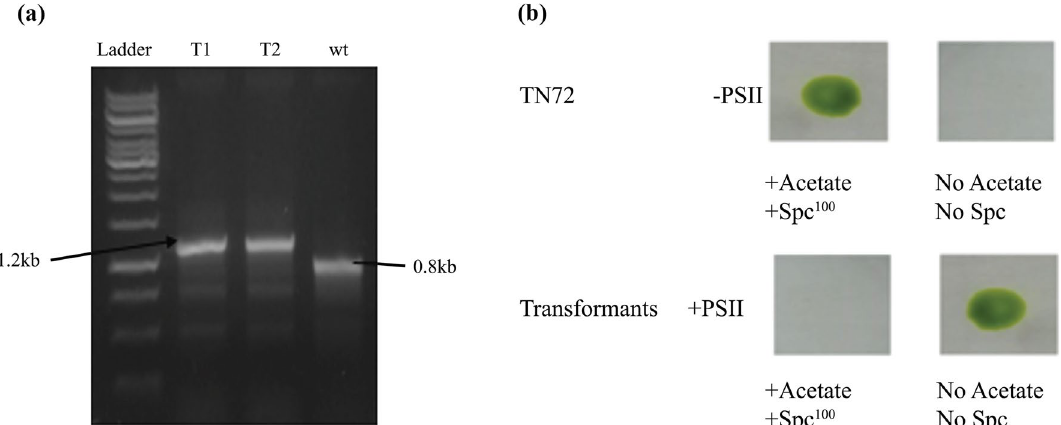
Fig. 3 Confirmation of homoplasmy by PCR and spot test. a The original strain of Chlamydomonas reinhardtii TN72 gives a product of 0.88 kb with F1 and R1 primers, while the transformants yield a product of 1.2 kb with some non-specific amplifications. The presence of a 1.2 kb band instead of a 0.88 kb band confirms that all transformants are homoplasmic. b Spot test shows that the original strain of TN72 grows in the presence of spectinomycin (spec) as it consists of spec resistant cassette (upper panel), which is lost after transformation due to which homoplasmic transformants cannot manifest phototrophic growth in the presence of spectinomycin (lower panel). absence of photosystem II